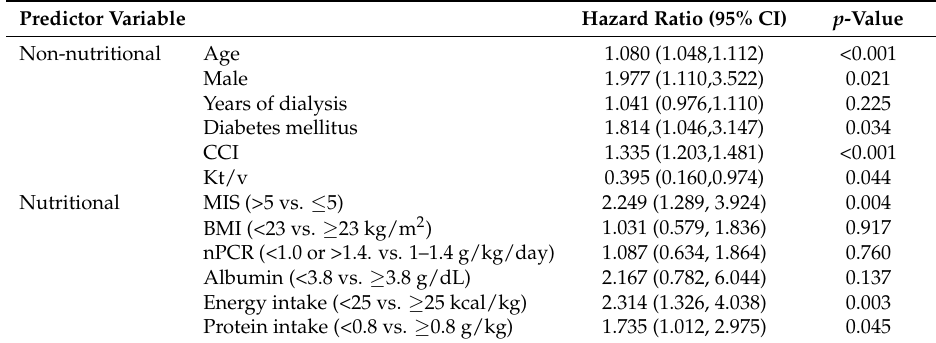
Table 5. Univariate Cox proportional hazards analysis of all ‐ cause mortality in end ‐ stage renal disease patients on maintenance hemodialysis.